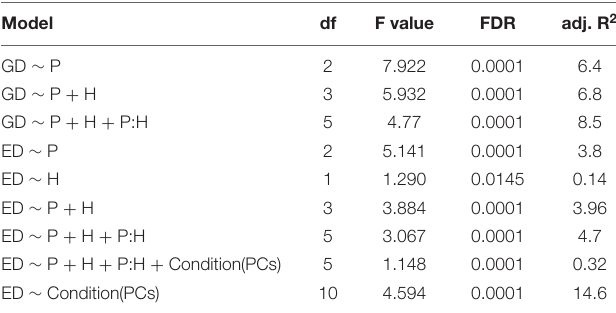
TABLE 2 | Results of the distance-based redundancy analysis (dbRDA) showing the percentage of genetic and epigenetic variance explained by population (P), habitat (H), and/or their interaction (P:H).